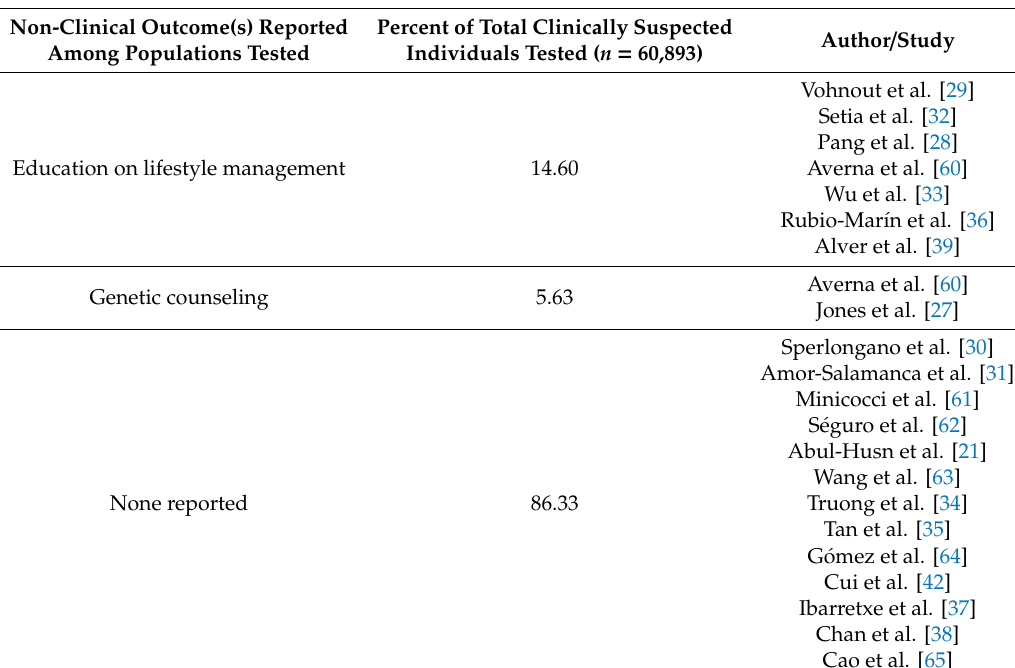
Table A3. Summary of Percent of Individuals Tested and Non-Clinical Outcomes Reported Following FH Genetic